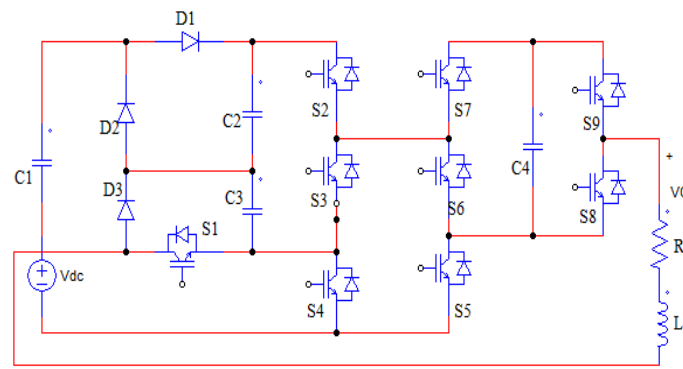
Figure 8. Nine-switch, nine-level topology Figure 8 . Nine-switch, nine-level topology [57].